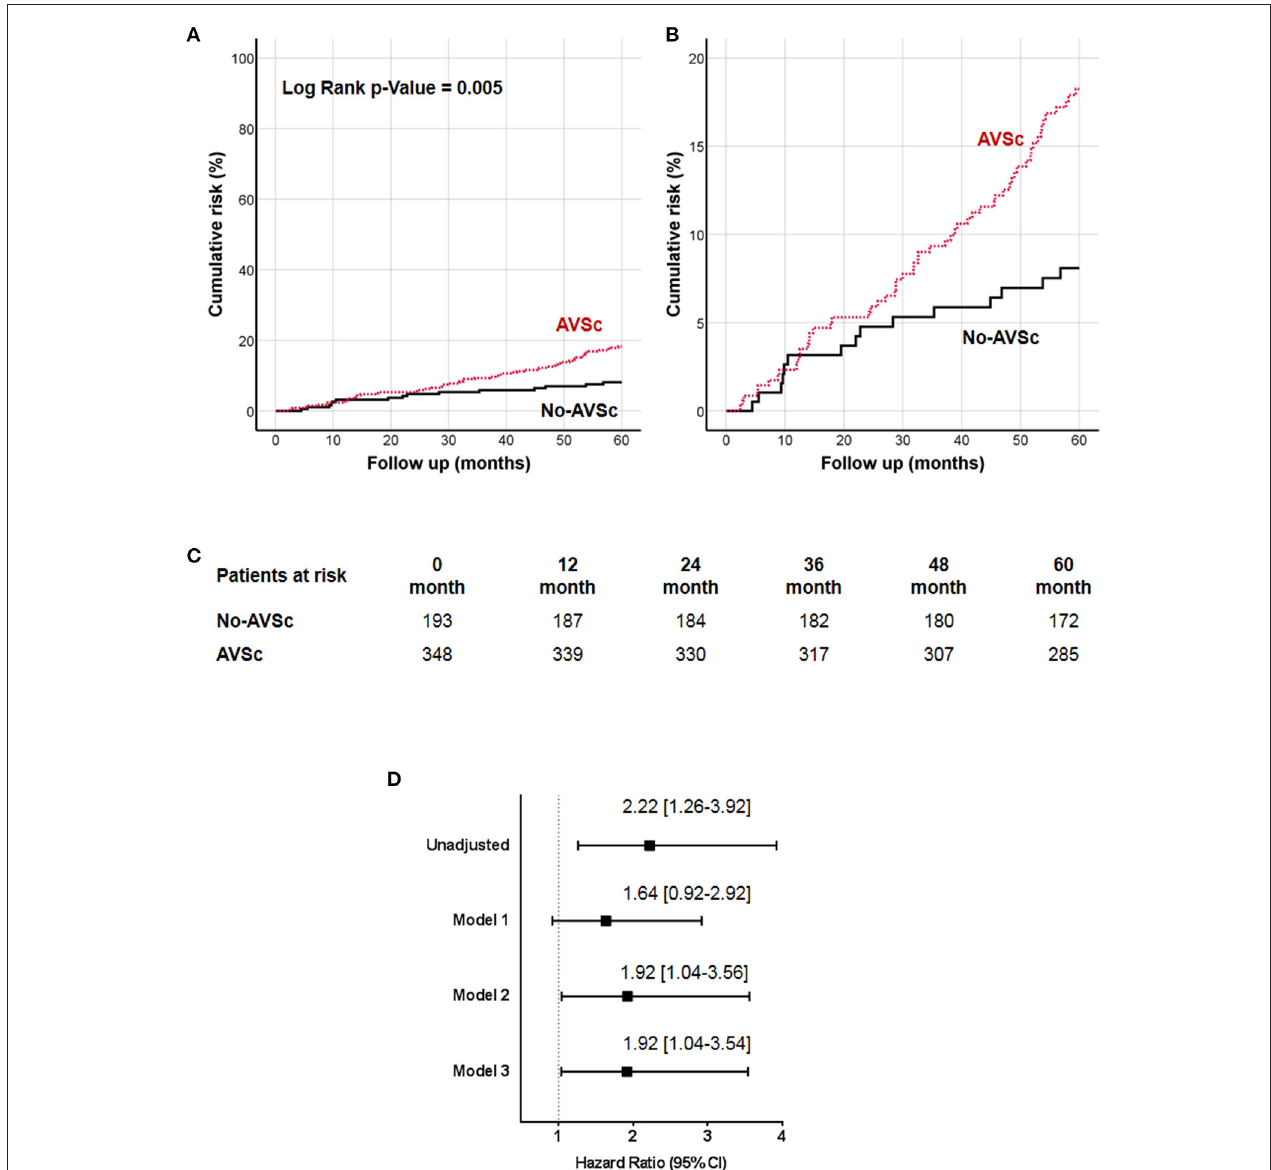
FIGURE 2 | Cumulative incidence curves for 5-year all-cause mortality. (A) All-cause mortality was compared between CEA patients with (red dash line) and without (black solid line) aortic valve sclerosis (AVSc). (B) Inset of (A) to better evidence the differences between the two groups. (C) Breakdown of the patients at risk per year in the two groups. (D) Cox regression analysis showing the hazard ratio (HR) unadjusted and adjusted for age (Model 1), for age and estimated glomerular filtration rate (eGFR; Model 2), and for age, eGFR, and left ventricular ejection fraction (LVEF; Model 3).